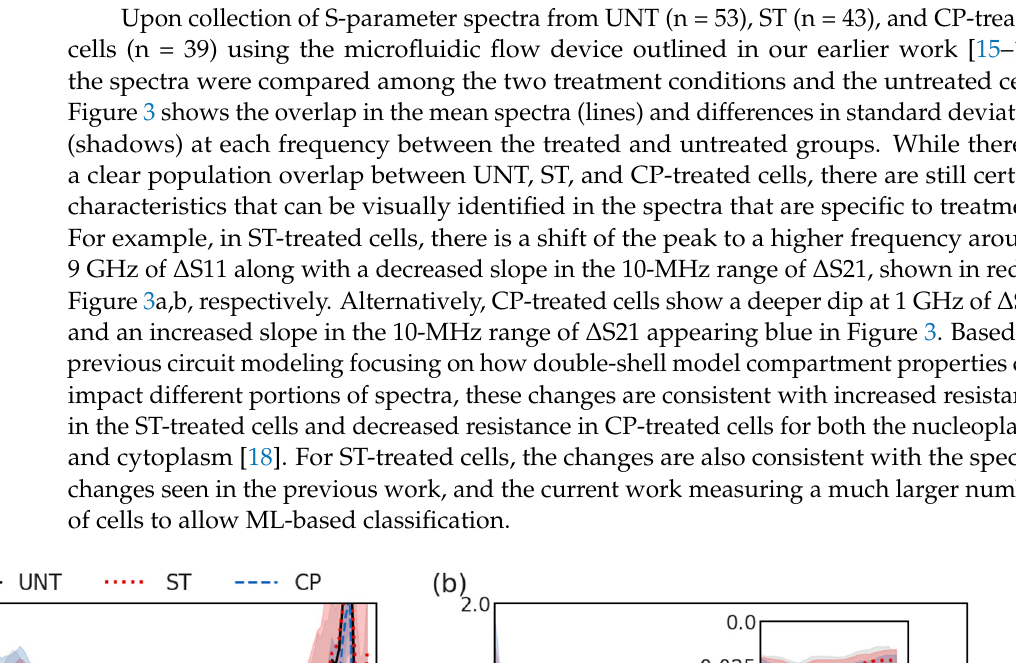
Figure 2. Cell and nucleus diameter measurements from fluorescence imaging. ( a ) Nucleus/cell diameter ratios among untreated, staurosporine (ST), and ciprofloxacin (CP) treated Jurkat cells. ( b ) Population cell diameter comparison among treatment types. (* p < 0.05, ** p < 0.01) Each box demonstrates the interquartile range (IQR) for the sample and the whiskers show the extension to 1.5 * IQR.